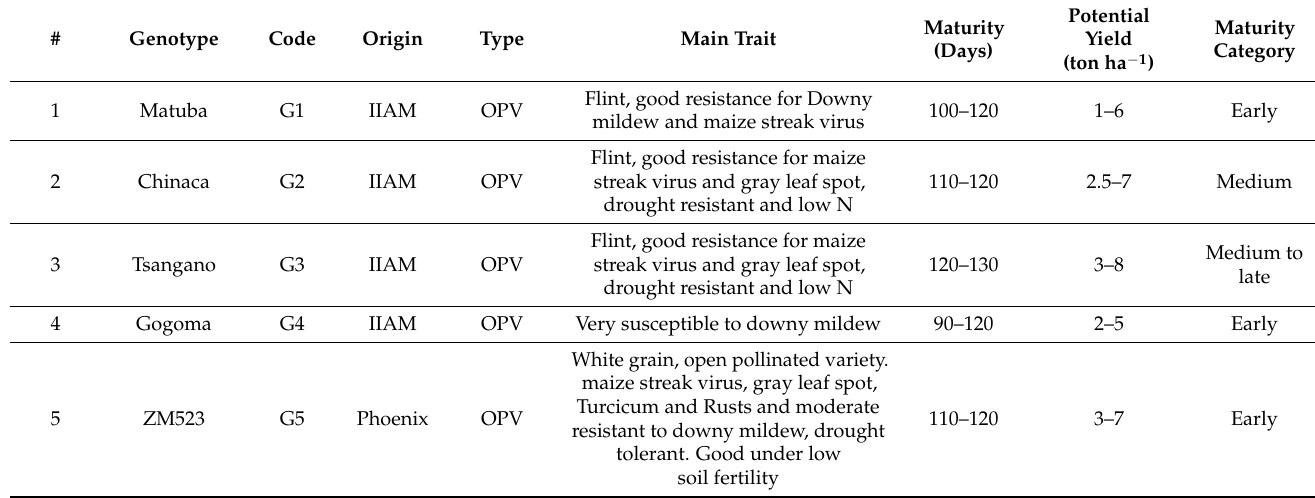
Table 2. Maize varieties assessed for yield in S á bie and Ch ó